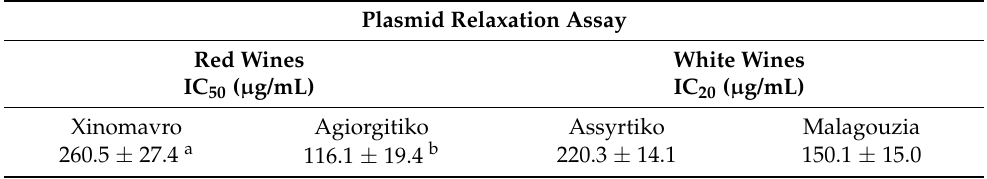
Table 3. Antigenotoxic activity of the tested wine extracts using a plasmid relaxation assay.